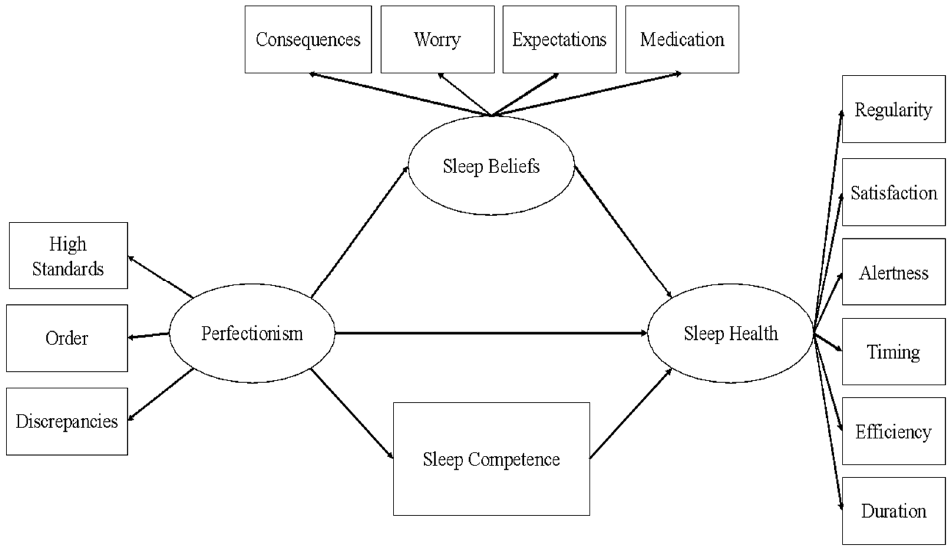
Figure 2. Structural equation model validating a hypothesized pattern of relationships among manifest and latent variables leading from perfectionism to sleep health.